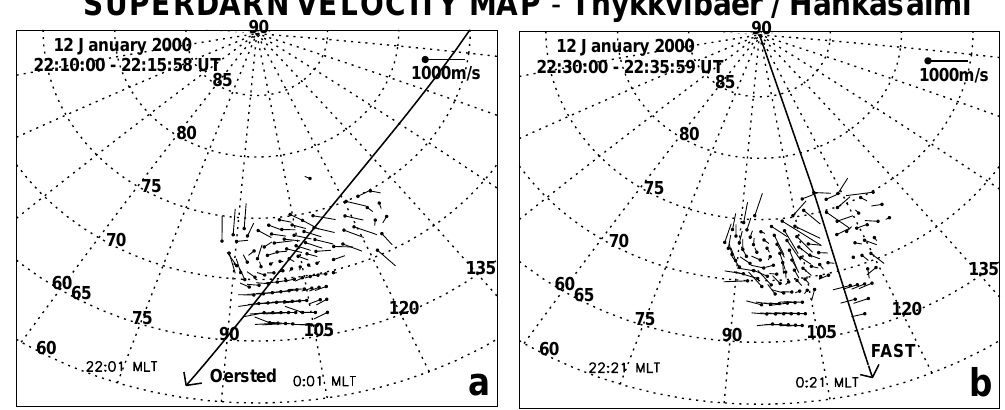
Fig. 4. Average (over 6min) convection velocity maps of the CUTLASS radars in AACGM coordinates. (a) at the time of the Ørsted pass 22:10–22:16 UT, with the Ørsted trajectory superimposed. (b) at the time of the FAST pass 22:30–22:36 UT, with the FAST trajectory